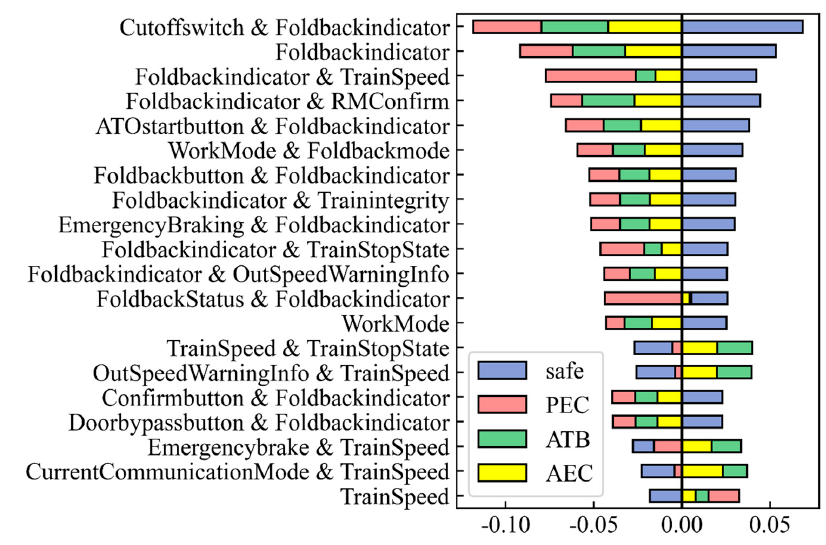
Figure 6. Feature importance score per class.